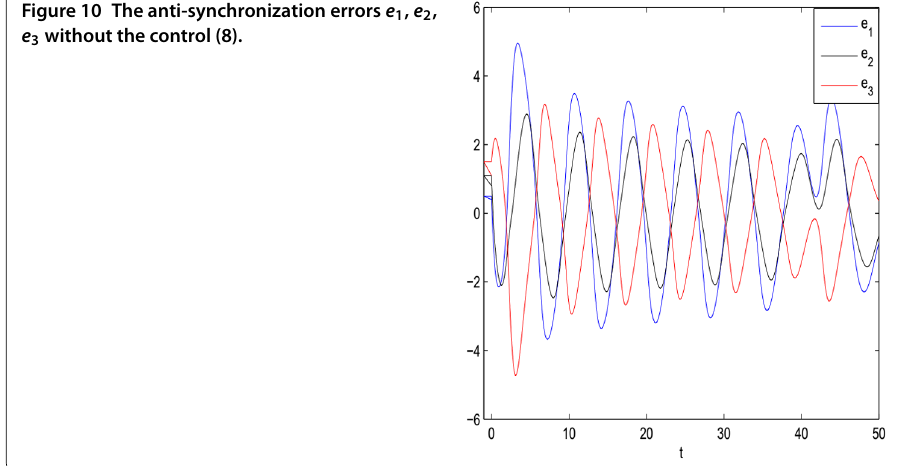
Figure 10 The anti-synchronization errors e 1 , e 2 , e 3 without the control (8).